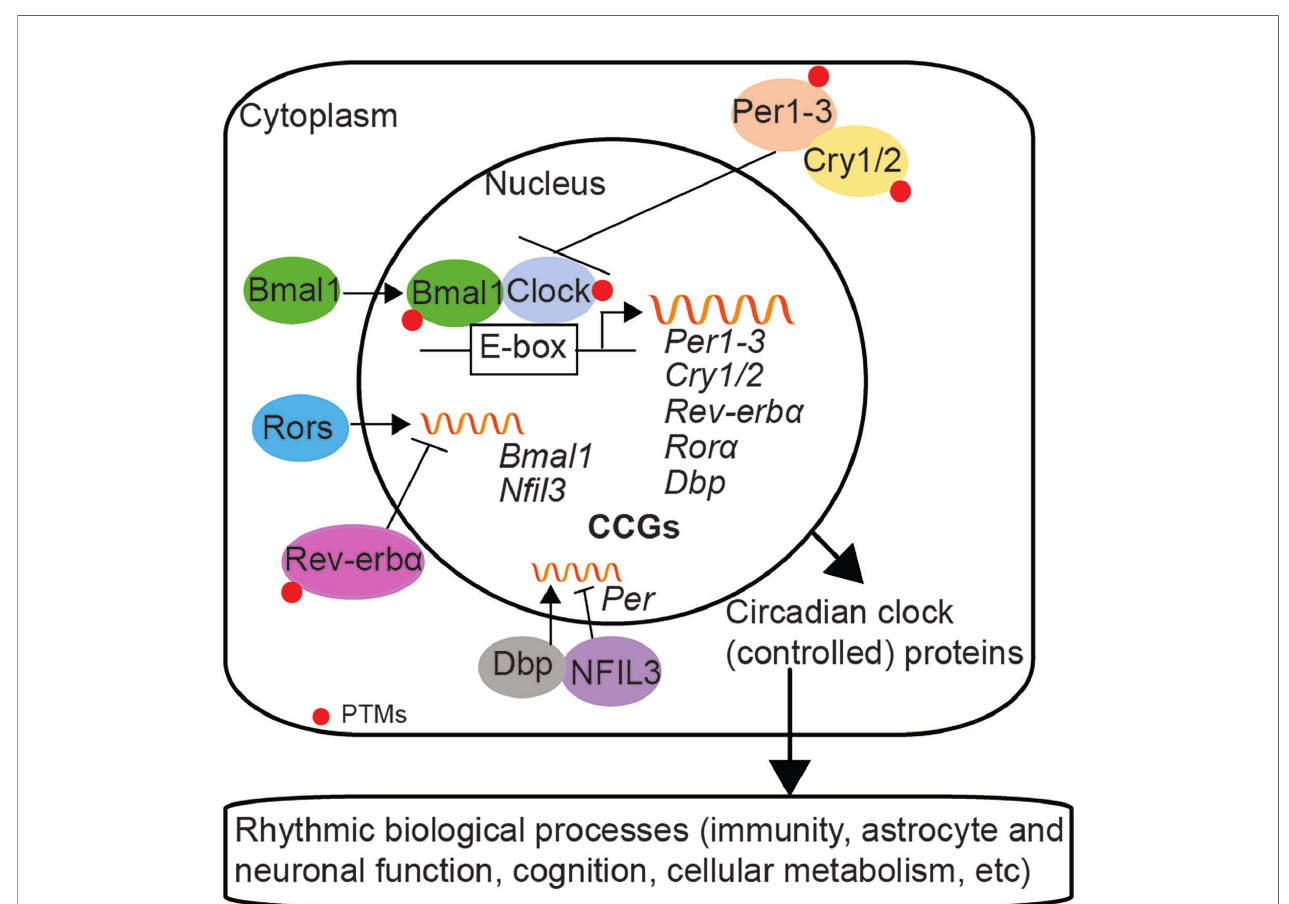
FIGURE 1 | The circadian clock machinery in mammals. The mammalian circadian clock network at the molecular level consists of transcription-translation feedback loops (TTFLs). Bmal1/Clock heterodimer activates the transcription of genes that containing E-box elements in their promoters, such as Per1/2/3 , Cry1/2 , Ror a , Rev- erb a , and Dbp. Per and Cry proteins translocate back into the nucleus and repress the activity of the Bmal1/Clock complex, which subsequently inhibits their own expression. Ror a and Rev-erb a fi ne-tune the expression of Bmal1 and N fi l3 , via activation and repression, respectively. DBP and NFIL3 regulate the expression of Per. Besides, the stability and nuclear translocation of circadian clock proteins are modulated by post-translational modi fi cations (PTMs). Circadian clocks also control the rhythmic expression of numerous clock-controlled genes (CCGs) and biological processes, such as immunity and brain